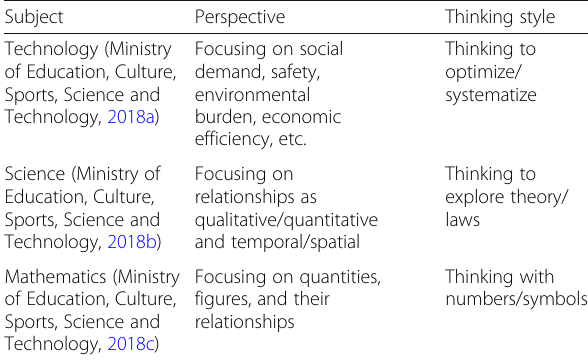
Table 1 “ Perspectives and thinking styles ” of